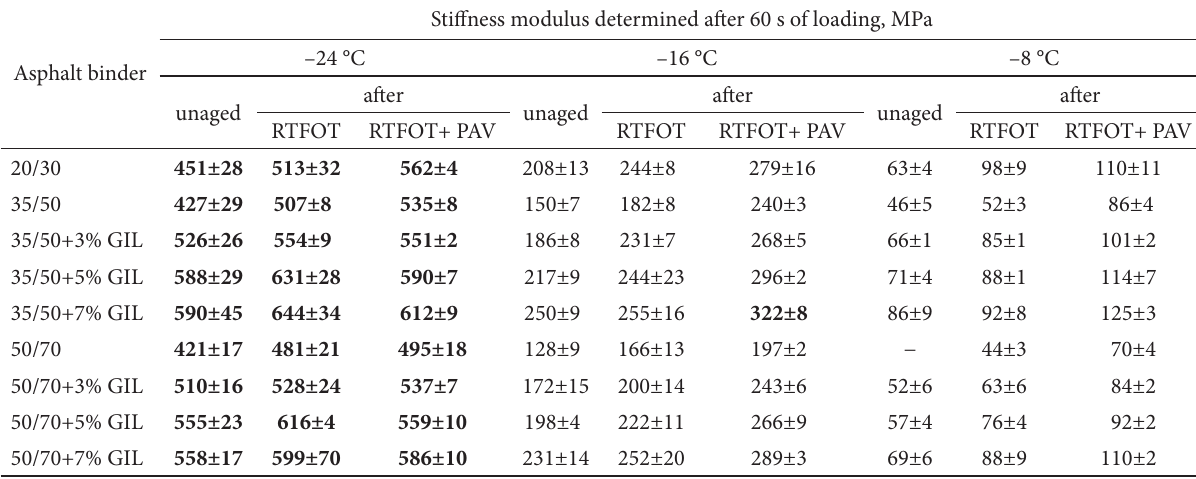
Table 3. Results of the stiffness modulus determination at –24 °C, –16 °C and –8 °C for the Gilsonite modified asphalt binders